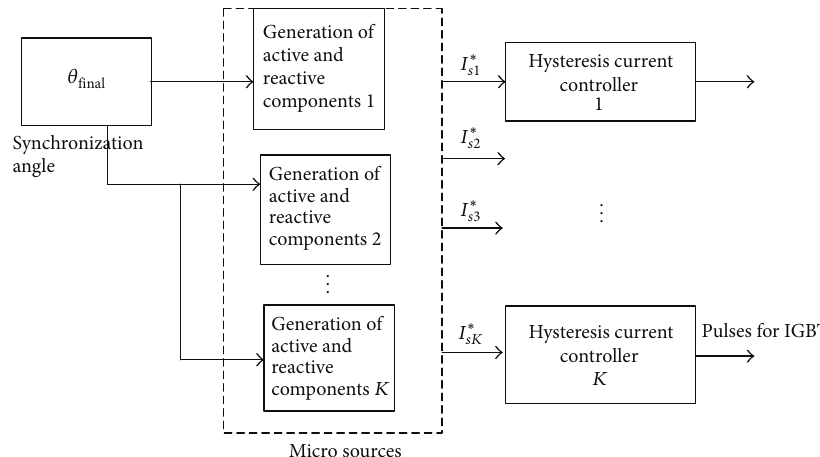
Figure 7: Centralized control scheme for microgrid.